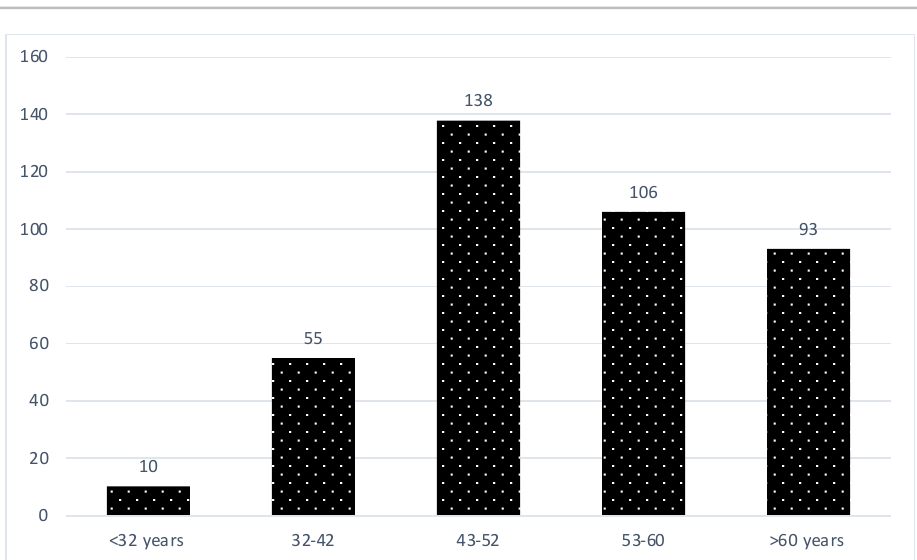
FIGURE 1 - Participants age